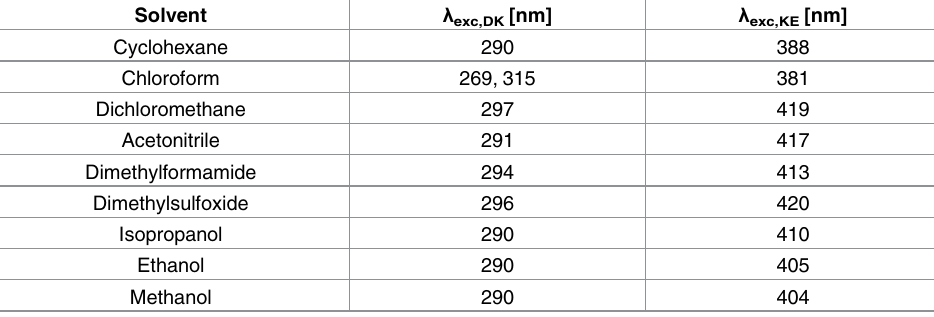
Table 5. Fluorescence excitation maximaof K2T23.